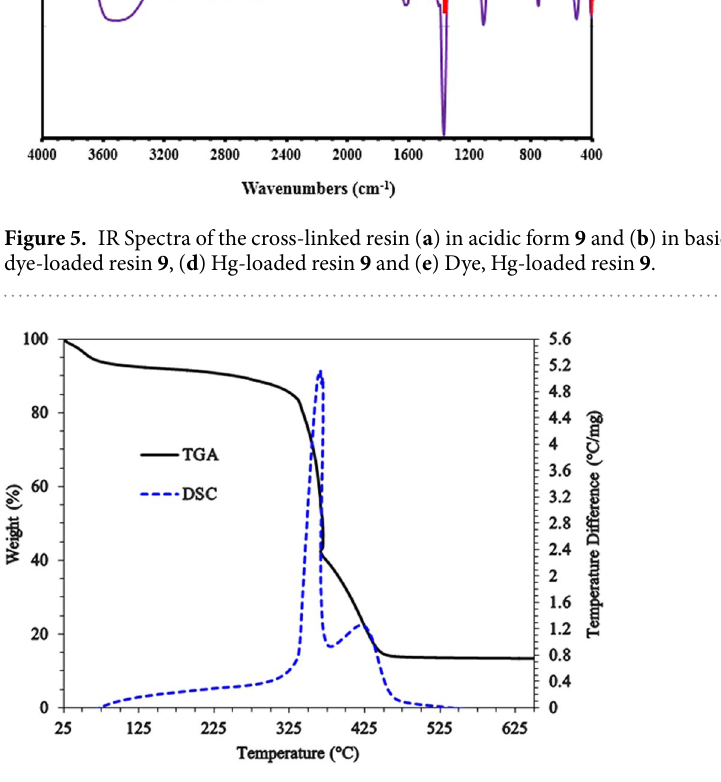
Figure 6. TGA curves of HCPZA 9